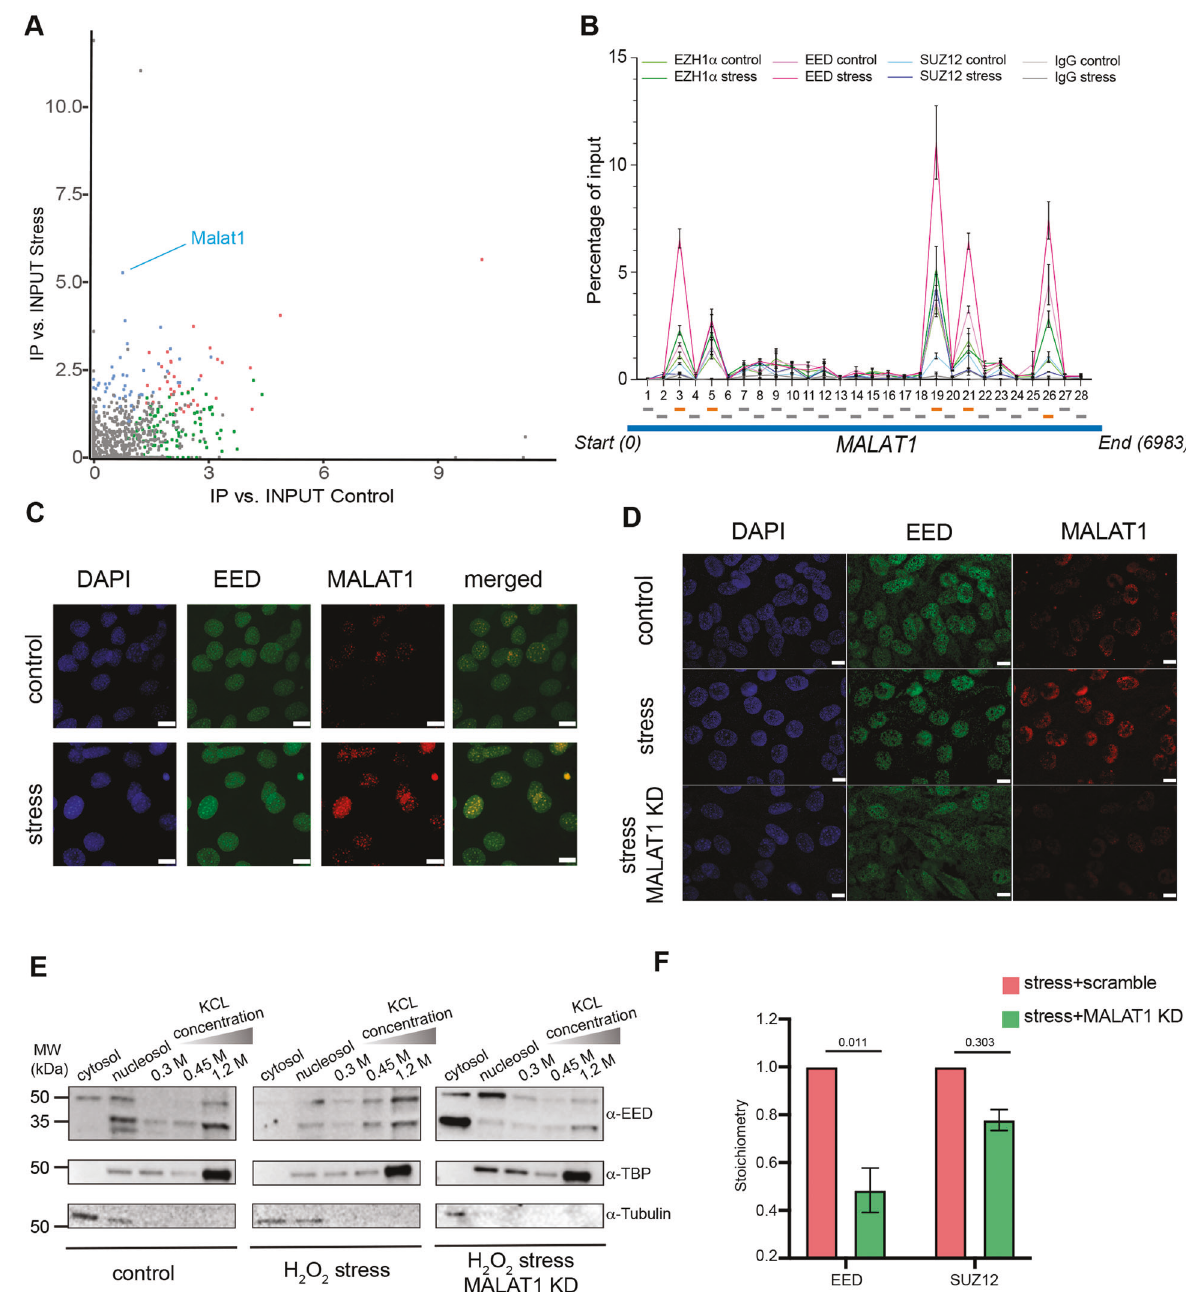
Fig. 1 Oxidative stress-induced EED nuclear localization and PRC2-Ezh1 complex stability is supported by Malat1. A Scatter plot analysis of EED interacted lncRNA relative intensity in comparison with stress and control conditions. Blue, green, and red dots represent signi fi cantly enriched lncRNA bound by EED under stress condition, normal condition, and shared between stress and control conditions, respectively. Gray dots indicate background lncRNA signals. B CLIP-qPCR analysis to map direct interaction between MALAT1 and PRC2-EZH1a components. Relative amounts of each endogenous MALAT1 RNA regions was normalized to input for EZH1 α , SUZ12, EED, and IgG using indicated color. Error bars represent ± SD from three biological replicates. Schematic illustration indicates fragments ampli fi ed in qPCR. C Colocalization of EED (green) and Malat1 (red) was measured using immuno-RNA FISH. DNA was counterstained with DAPI (blue). Scale bar = 10 µm. D Immuno-RNA FISH to detect EED (green) and MALAT1 (red), DNA was counterstained with DAPI (blue). Control and stress conditions were described as in C . MALAT1 KD show knockdown of MALAT using GAPMERS ASO. Scale bar = 10 µm. E Immunoblot analysis of EED distribution in the cytosol, nucleosol, and chromatin fractions. TBP and Tubulin were used as cytosol and chromatin fraction control. Indicated conditions have been described in D . F Stoichiometry of Ezh1a interactors EED and SUZ12 under stress conditions treated with wither scramble control or Malat1 ASO. Data are shown as mean ± SD ( n = 3 independent tandem af fi nity immunoprecipitation). P -value shown on top of each graph using the t -tests (and nonparametric tests) in GraphPad Prism version 8. Relatively normalized DIA value of indicated conditions were